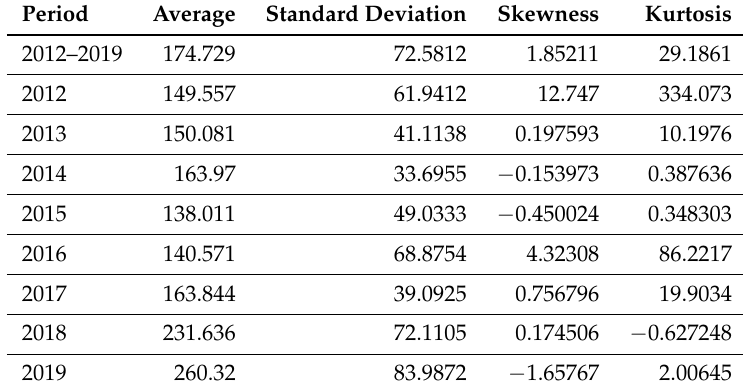
Table 1. Descriptive statistics of electricity spot prices (in TRY) in Turkish market. Period Average Standard Deviation